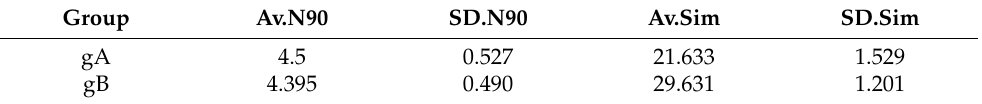
Table A3. Average results table obtained using the N90_resampling function from the $N90_mean values object. Av.N90 and the SD.N90 are the N 90 value and its standard deviation, respectively; Av.Sim and SD.Sim are the average and standard deviation values of the within-group similarity.